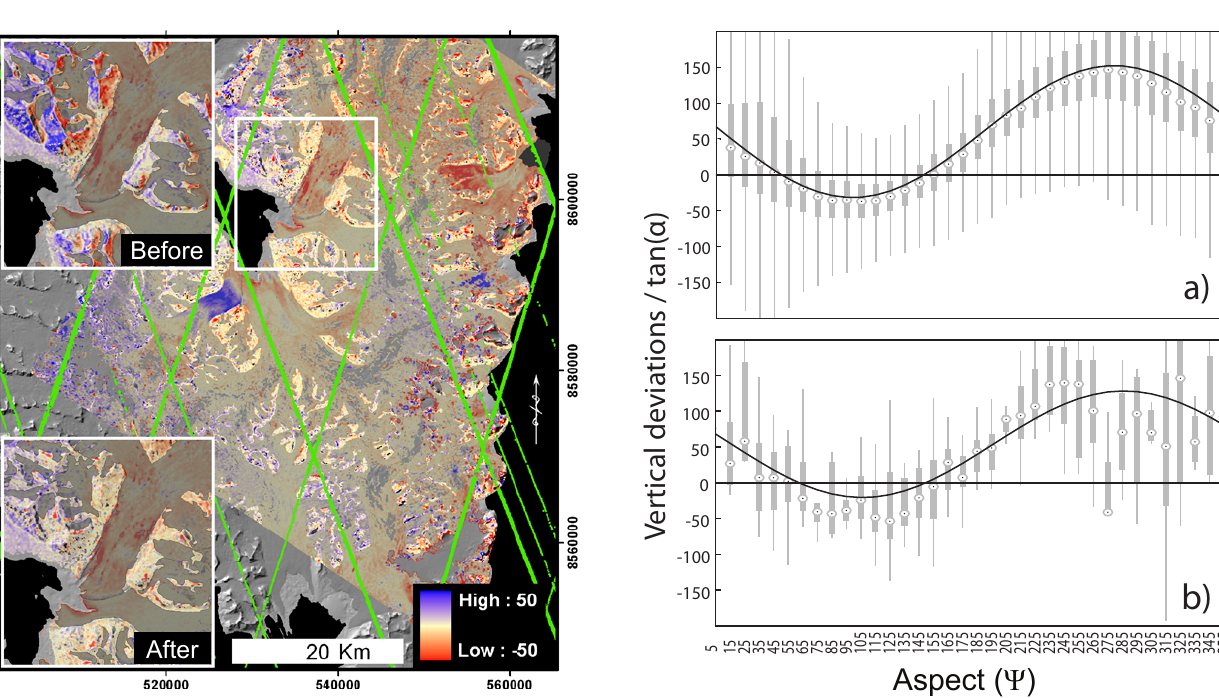
Fig. 9. The first iteration of the co-registration between the ASTER DEM and the aerophotogrammetric DEM (a) and the ASTER DEM and ICESat (b)